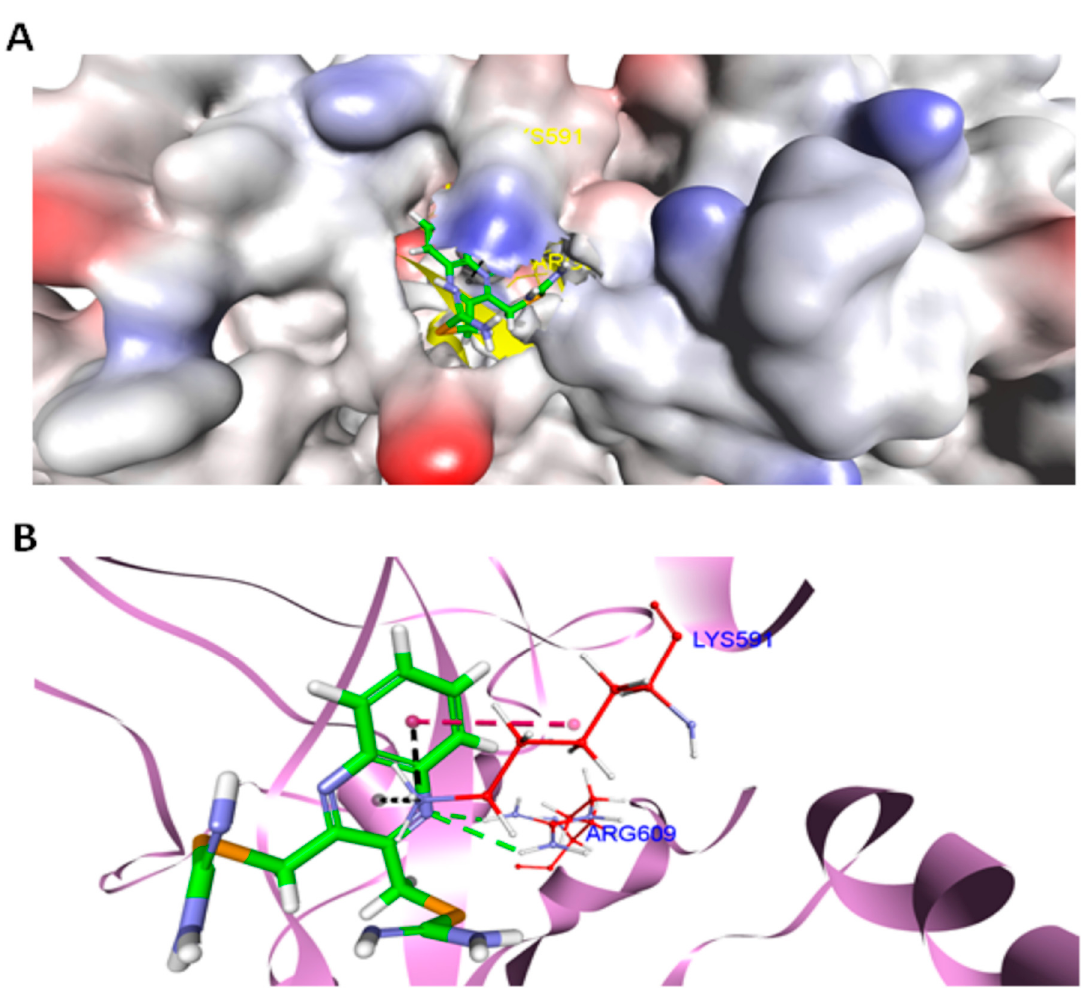
Figure 8. Docked complex of compound 1 with STAT3. ( A ) The surface representation of STAT3 showing deep penetration of compound 1 into the SH2 domain of STAT3 (pdb id: 1BG1), generated by DS (Accelrys). ( B ) Docked conformation of compound 1 in the SH2 domain of STAT3 (pdb id: 1BG1), viewed by DS (Accelrys). Carbon atoms of compound 1 (in sticks format) are colored green. The interacting amino acids of the SH2 domain of STAT3 are colored in red. All other amino acids of STAT3 are depicted in violet (flat ribbon format). Hydrogen bonds are shown in green, electrostatic interactions in black, and hydrophobic interactions are shown as magenta dotted lines.